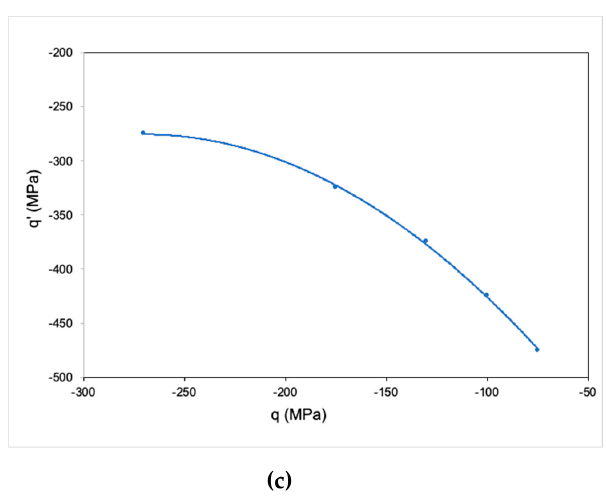
Figure 5. Dependence of ( a ) q’ in terms of the true strain, ( b ) q in terms of true strain and ( c ) q' in terms of q .